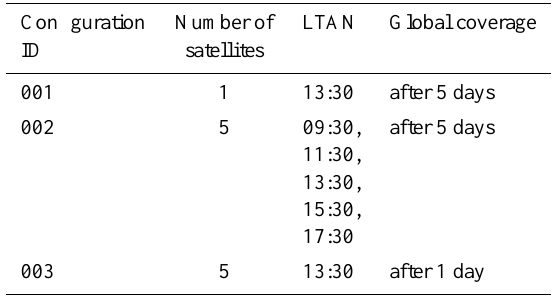
Table 1. Different CarbonSat configurations.